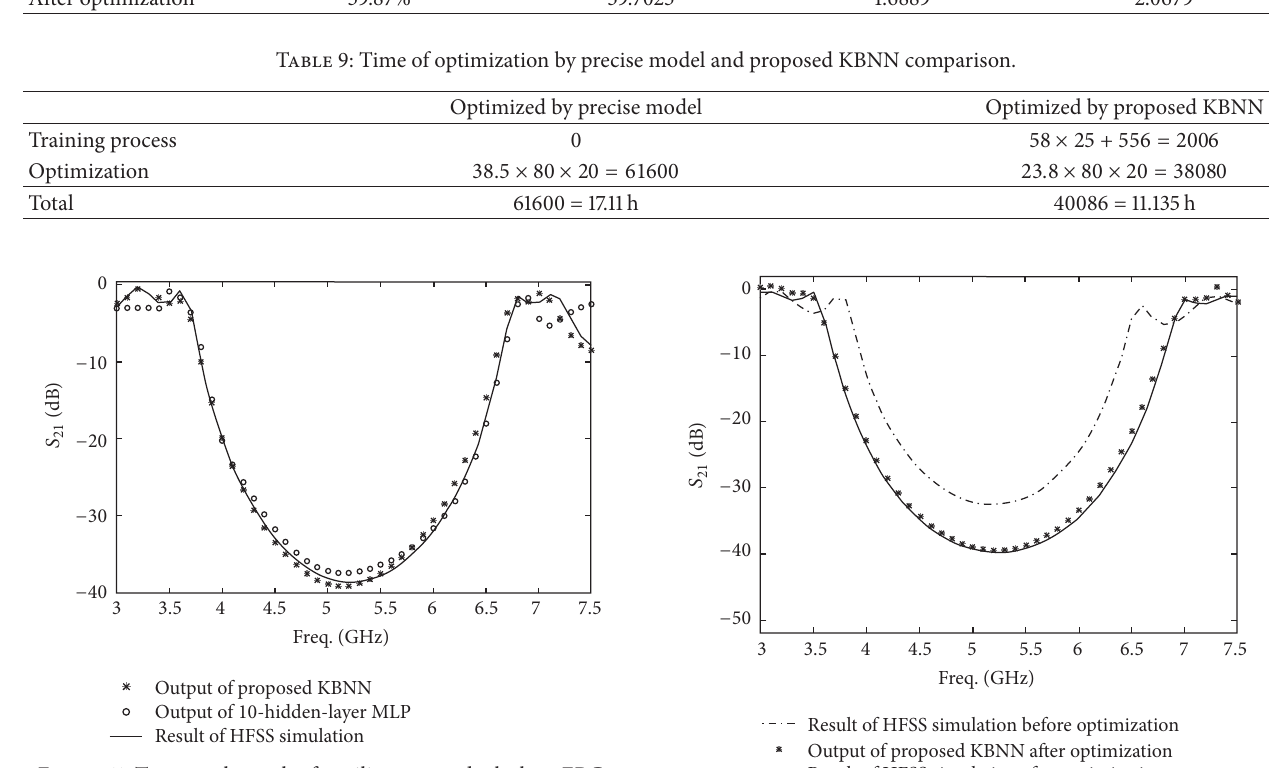
Figure 11: Test sample result of papilionaceous dual-plane EBG.